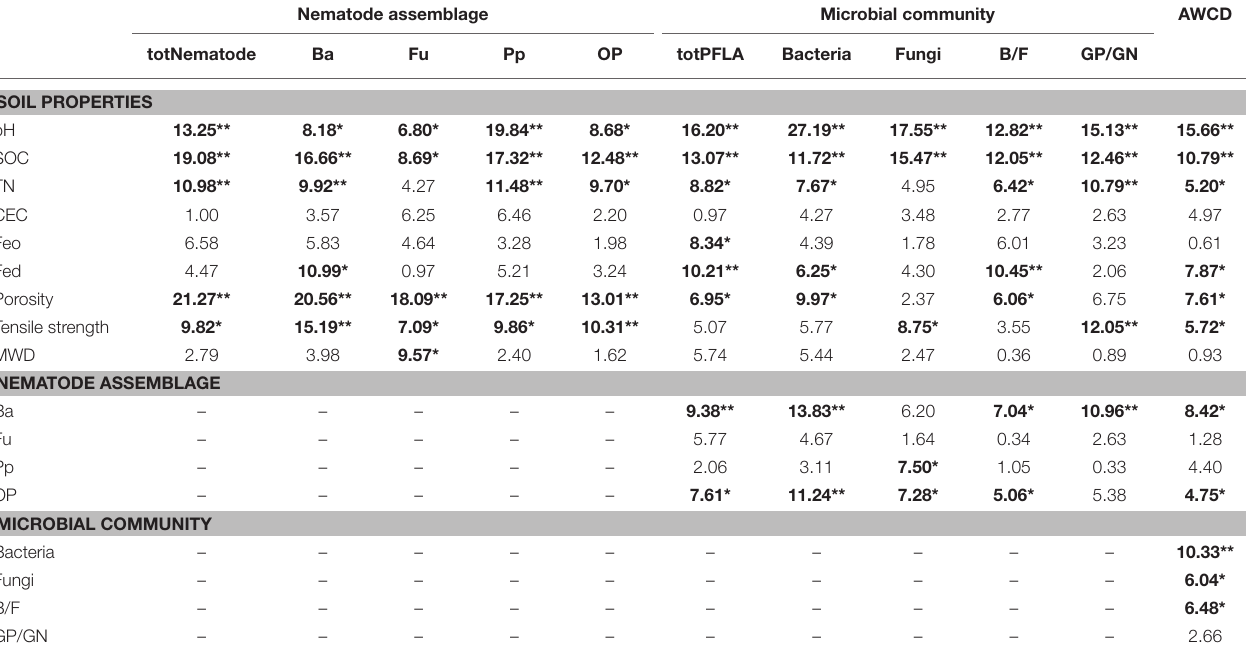
TABLE 1 | Relationships between soil properties, nematodes, microbial community and AWCD based on random forest analysis in the macroaggregates. Nematode assemblage Microbial community AWCD